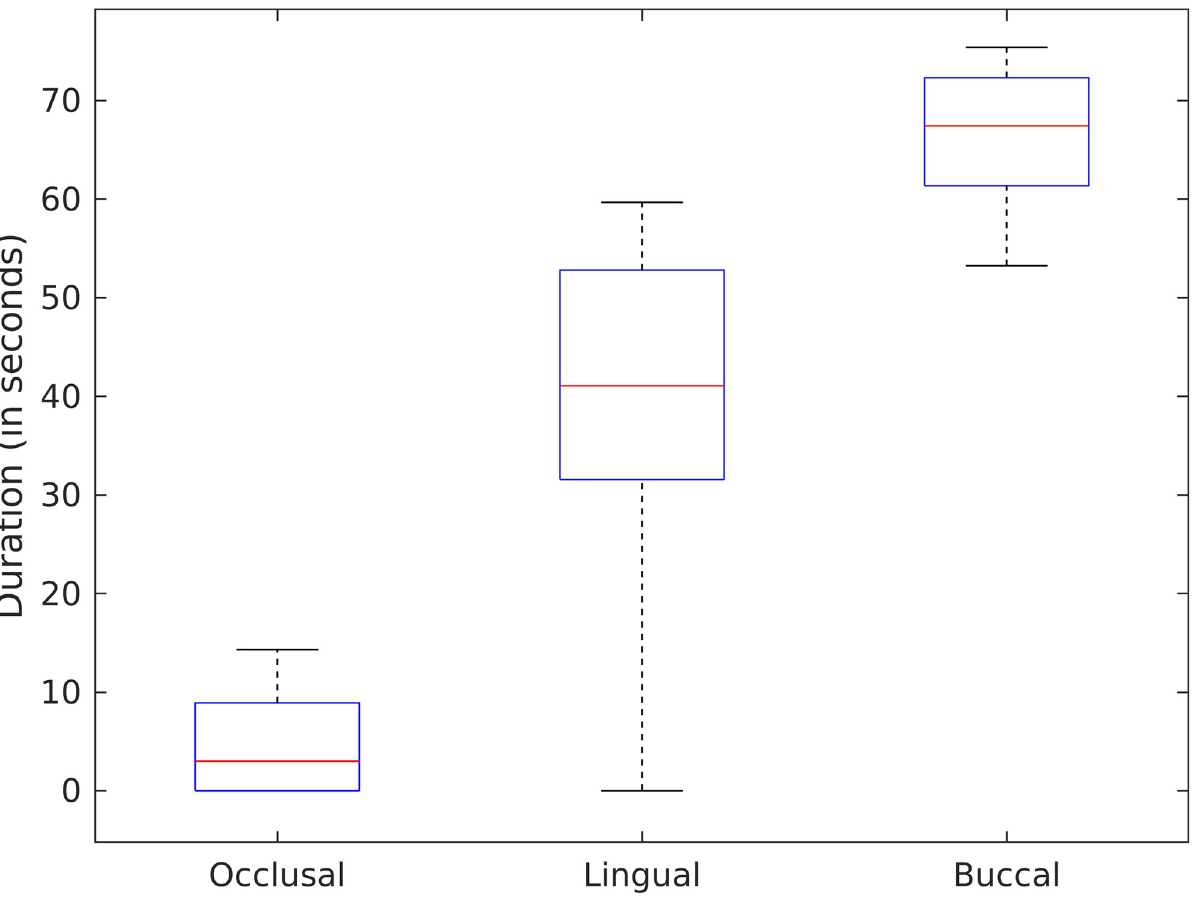
Fig 6. Within-individual variability in brushing duration for dental surfaces. Participant 2’s brushing duration for the lingual surfaces varied greatly across